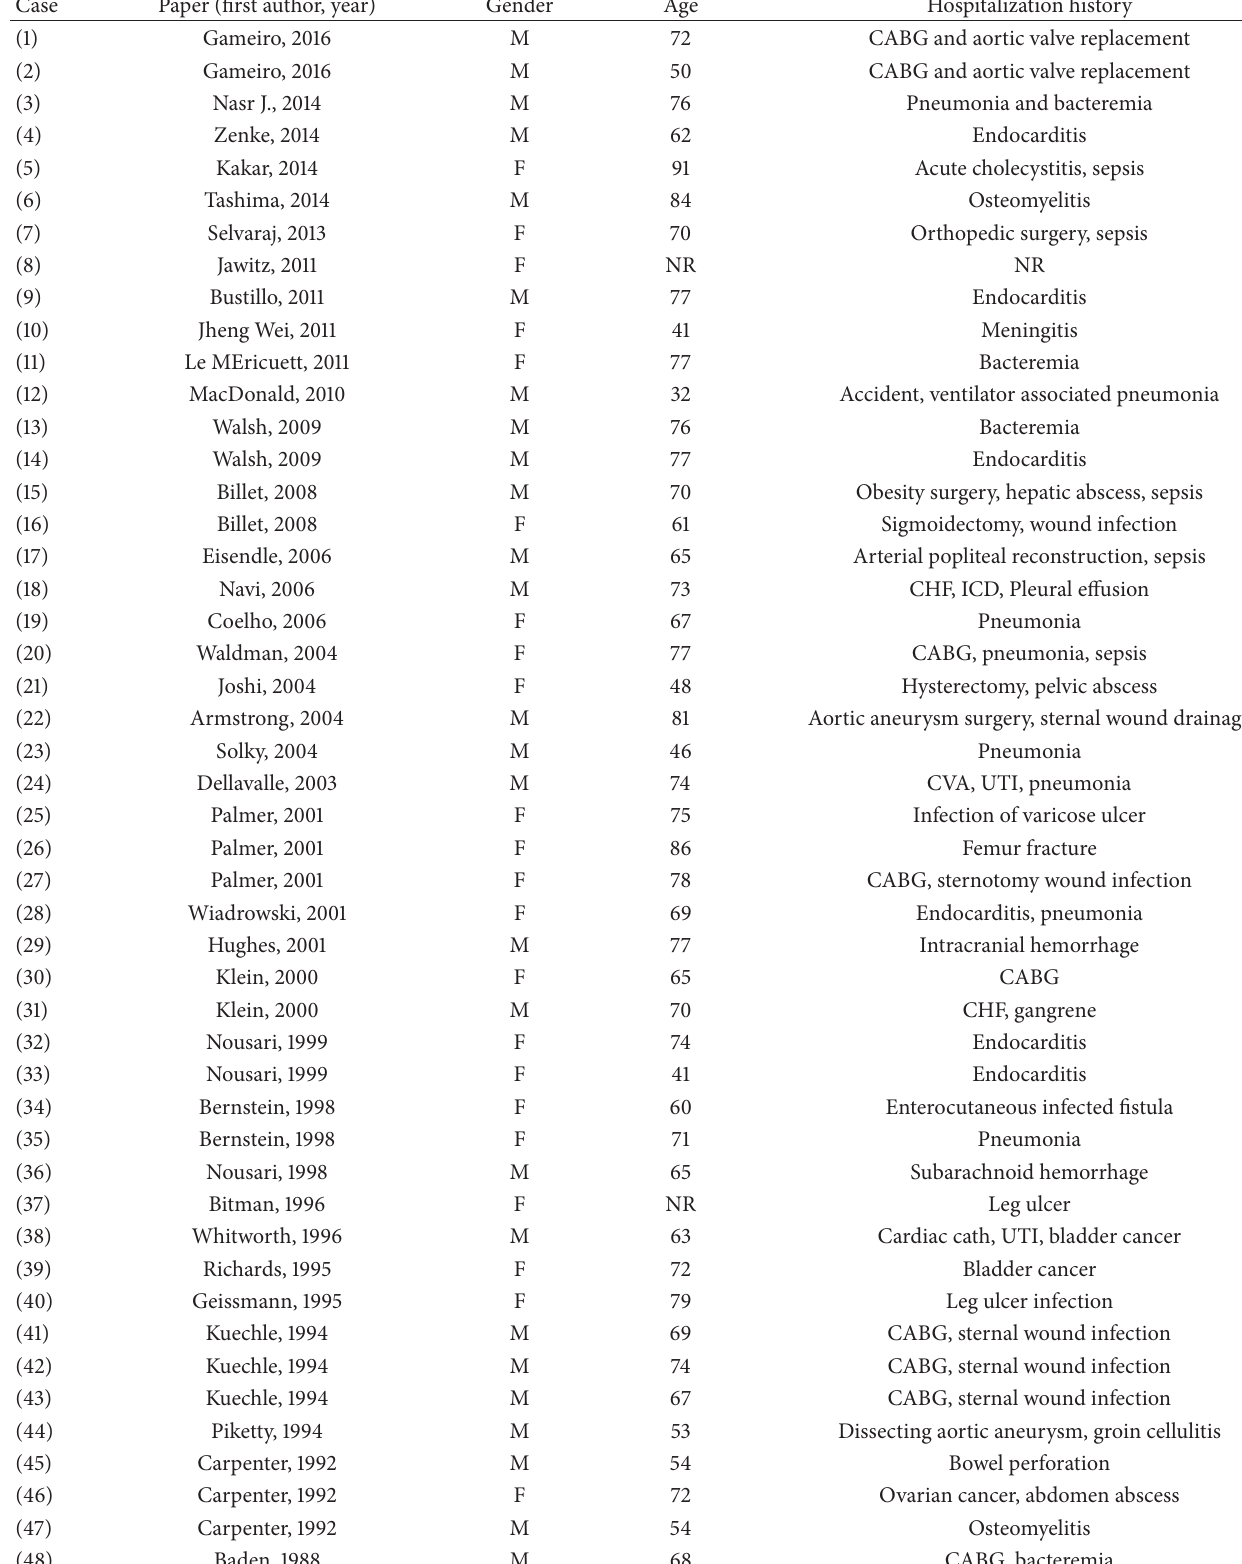
Table 1: Vancomycin induced LABD cases reported between 1988 and